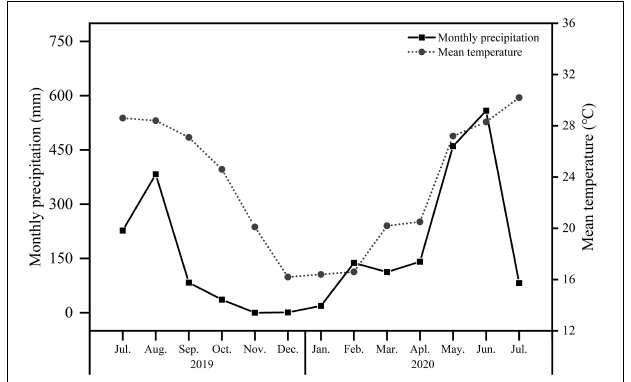
Figure 1 | Monthly precipitation and mean temperature during the experimental period from July 2019 to July 2020. The dot with the broken line represented the mean temperature and the square with solid line indicated the monthly